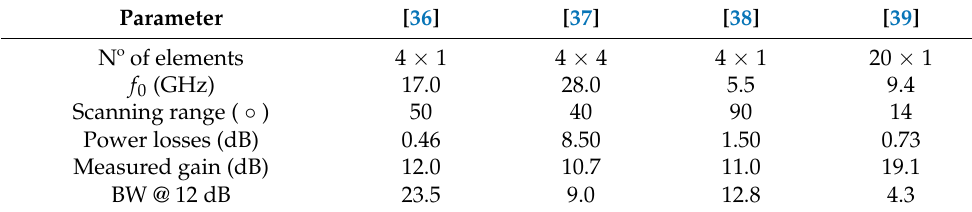
Table 3. Comparison of phased arrays with beam-steering